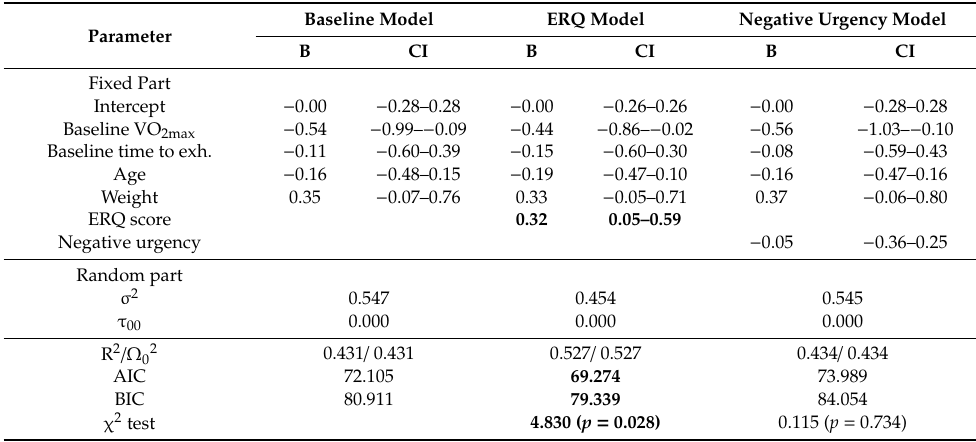
Table 2. Unstandardized estimates and confidence intervals for model parameters, explained variance, and goodness-of-fit indices in all fitted